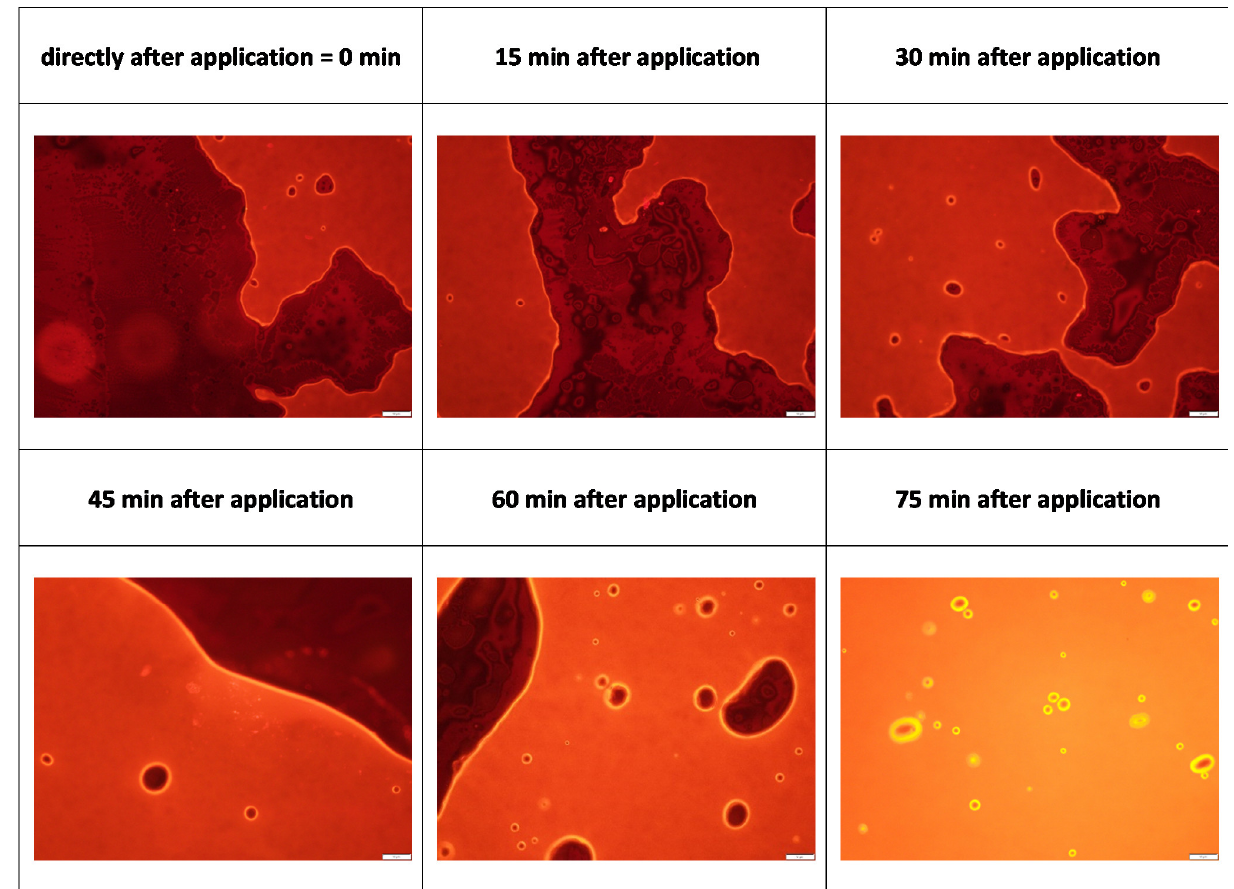
Figure 4. Images of Vaseline obtained from inverted epifluorescence microscopy. Images were taken at different time points (0–75 min). Images show the formation of a liquid film underneath the semi-solid Vaseline. The film appears immediately after application and increases over time until the whole interface between the microscope slide and Vaseline is filled with the film. By considering the microscope slide as a surrogate for the skin surface, images provide evidence that Vaseline undergoes syneresis after dermal